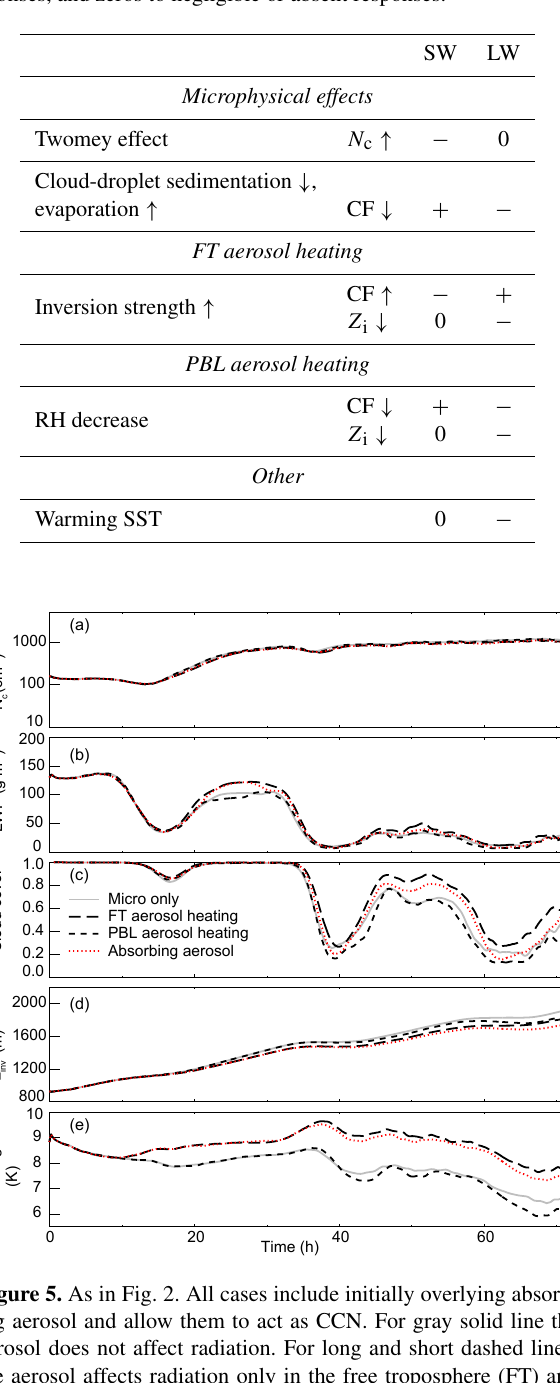
Table 5. Schematic of SW and LW radiative responses (changes in net downward fluxes at TOA) to microphysical and thermal effects of the initially overlying absorbing aerosol layer. N c refer to cloud- droplet concentrations, CF cloud fraction, and Z i inversion height. Plus signs refer to positive responses, negative signs to negative re- sponses, and zeros to negligible or absent responses.